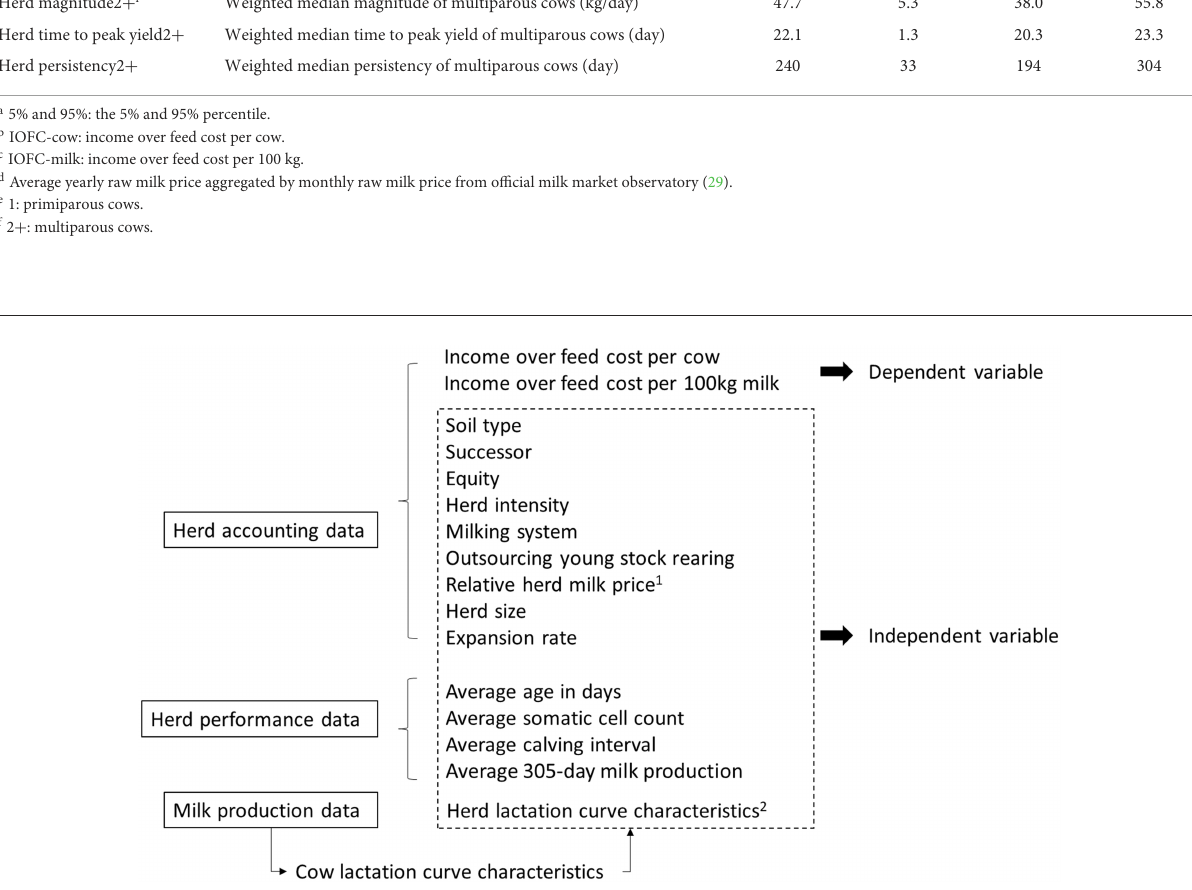
FIGURE1 Overview of variables used in the statistical analyses and the dataset they originate from. 1 the difference in milk price and the Dutch raw milk price for the corresponding year. 2 herd magnitude, herd time to peak yield and herd persistency for primiparous cows and multiparous cows